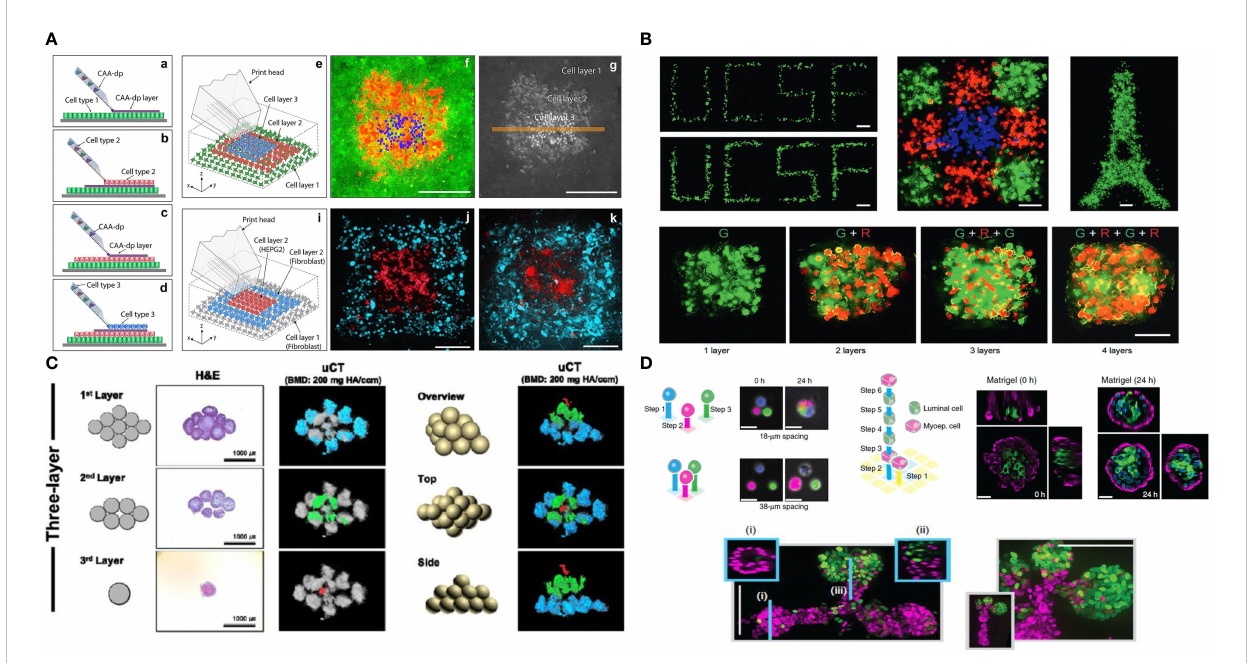
FIGURE 5 Future possibilities with single cell patterning of the tumor microenvironment (A) . Direct 3D cell bioprinting, open-volume micro fl uidics to position individual cells in a complex 3D patterns panel (A) adapted from Jeffries, et al. (2020) Scienti fi c Reports (144) (B) . High-de fi nition single-cell printing droplet method for cell by cell fabrication of biological structures panel (B) reproduced from Zhang, et al. (2020) Advanced Materials (145). (C) . 3D bioprinting of spheroids, 3D Bioprinting of hMSC/HUVEC spheroids via Aspiration-assisted Bioprinting panel (C) adapted with permission from